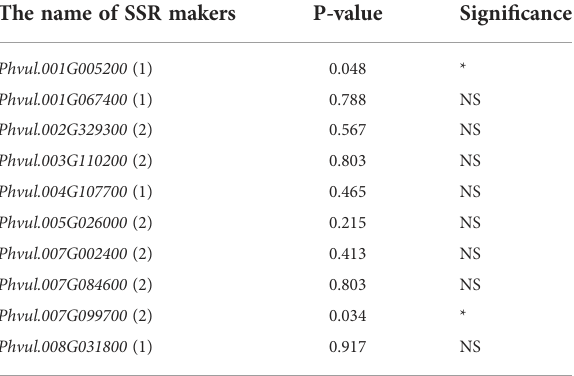
TABLE 2 The molecular markers associated with exogenous melatonin response under salt stress. The name of SSR